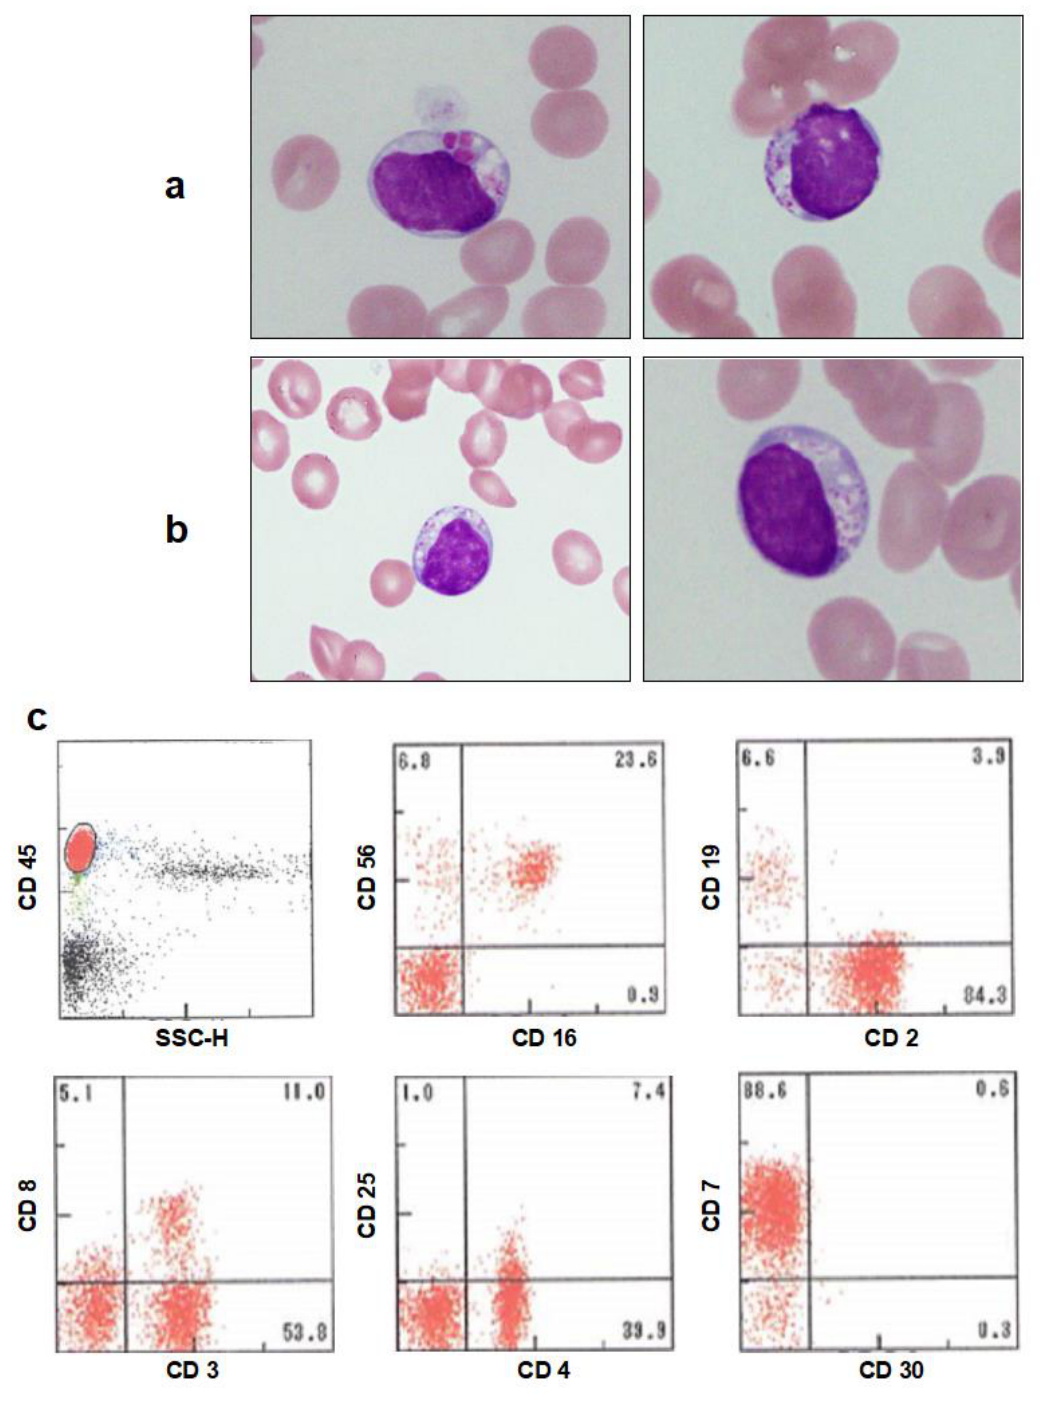
Figure 1. Natural killer cell large granular lymphocyte (NK-LGL) lymphocytosis induced by gilteritinib. ( a , b ) May Giemsa stained ( a ) peripheral blood and ( b ) bone marrow smear; original magnification × 400. ( c ) Flow cytometry analysis of lymphocytes in peripheral blood.